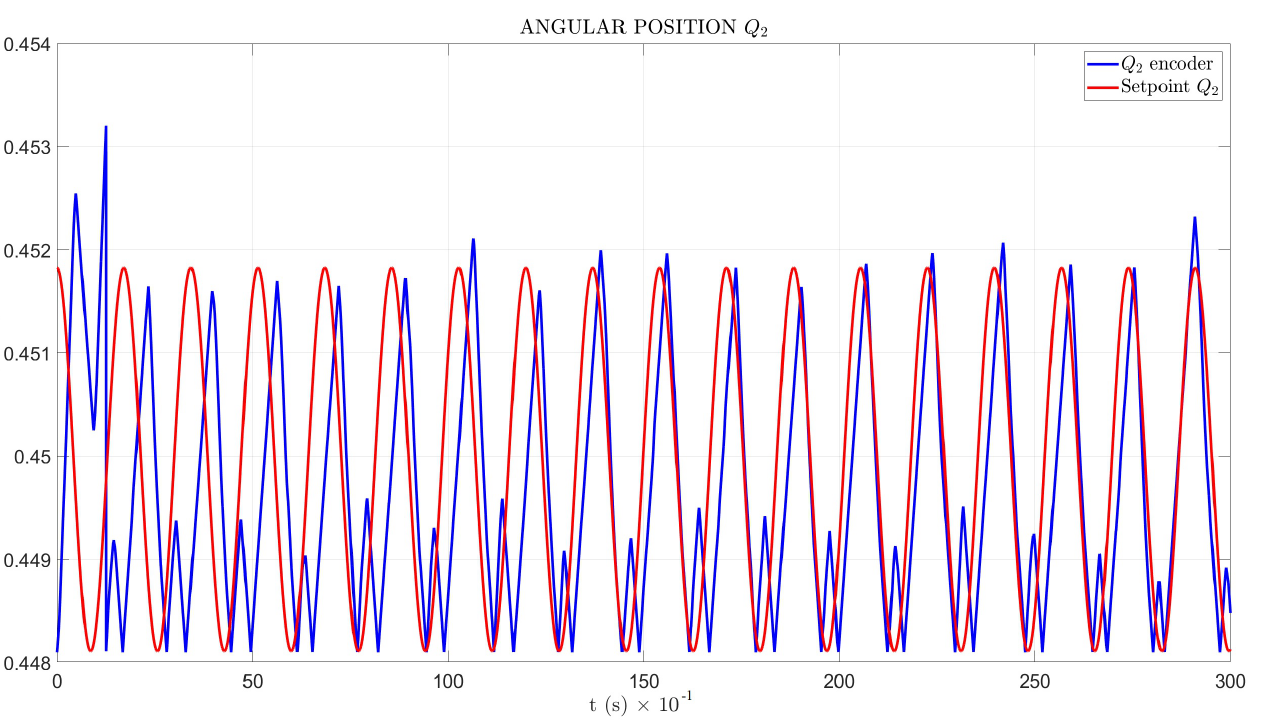
Figure 18. Angular position for Q 2